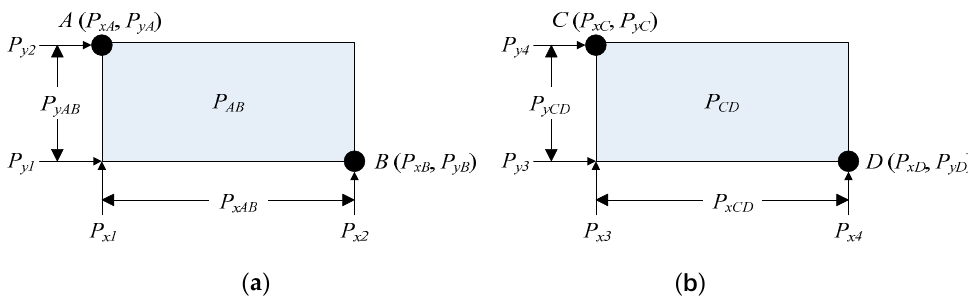
Figure 5. Spatial region graph. ( a ) The spatial region consisting of points A and B; ( b ) the spatial region consisting of points C and D.